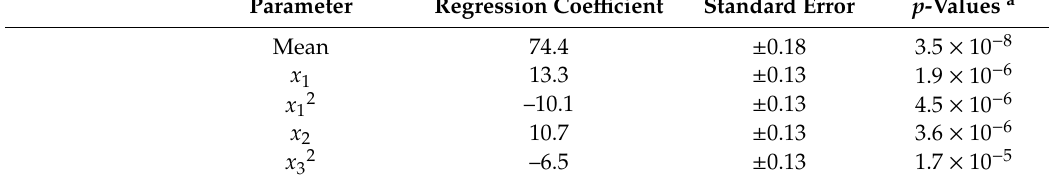
Table 3. Regression coe ffi cients, standard errors and p -values and analysis of variance (ANOVA).